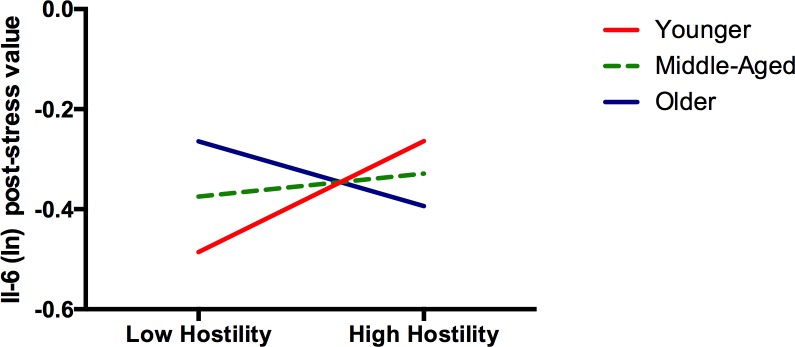
The Relation between Hostility and Il-6 Is Moderated by Age.Simple slope analyses indicate that among younger individuals, hostility was associated with greater Il-6 concentrations post stress compared to low hostile individuals (younger, b = 0.014, P = 0.001), whereas among older individuals, the opposite was true (b = -0.008, P = 0.047). In the intermediate age group, no significant relation was observed (b = 0.003, P = 0.338).